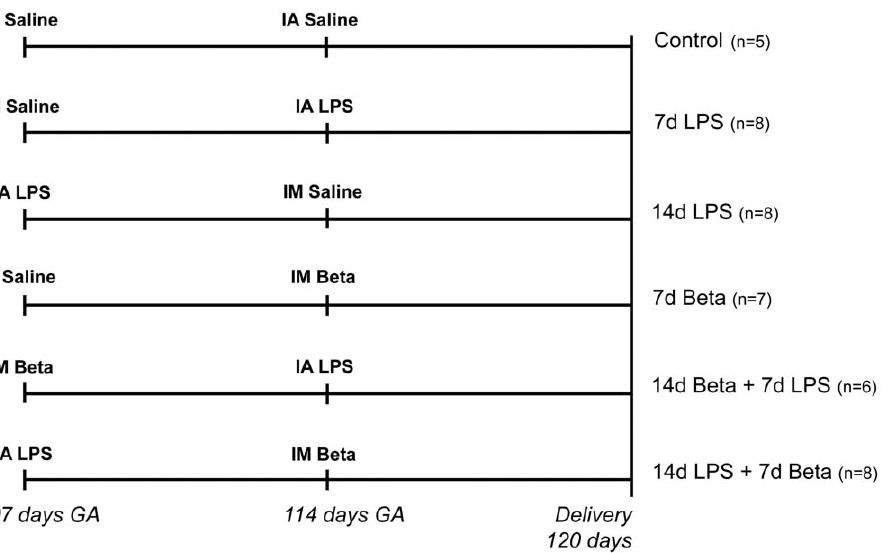
Figure 1. Study design. Pregnant ewes received an intra-amniotic injection of lipopolysaccharide (LPS) and/or a maternal intra-muscular injection of betamethasone (Beta) and/or an equivalent injection of saline for control animals at 107 days and/or 114 days gestation (GA). Lambs were delivered by cesarean section at 120 days GA (term=150 days GA).